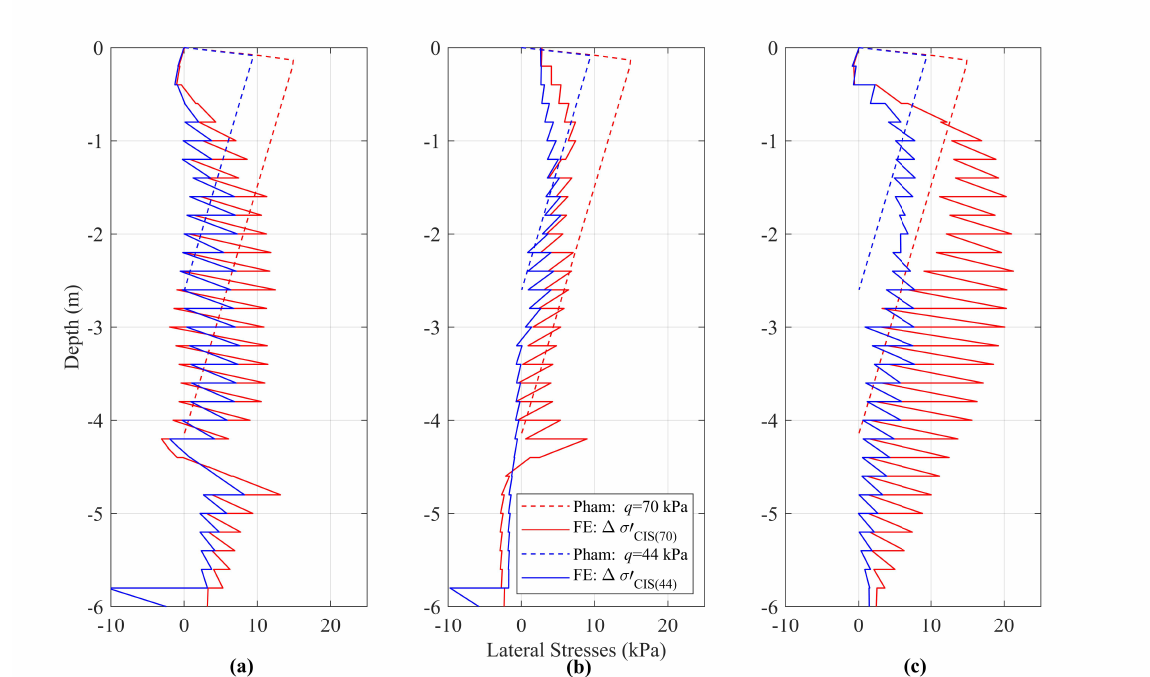
Figure 11. Comparison of CIS between analytical and numerical results for q = 44 and 70 kPa: ( a )